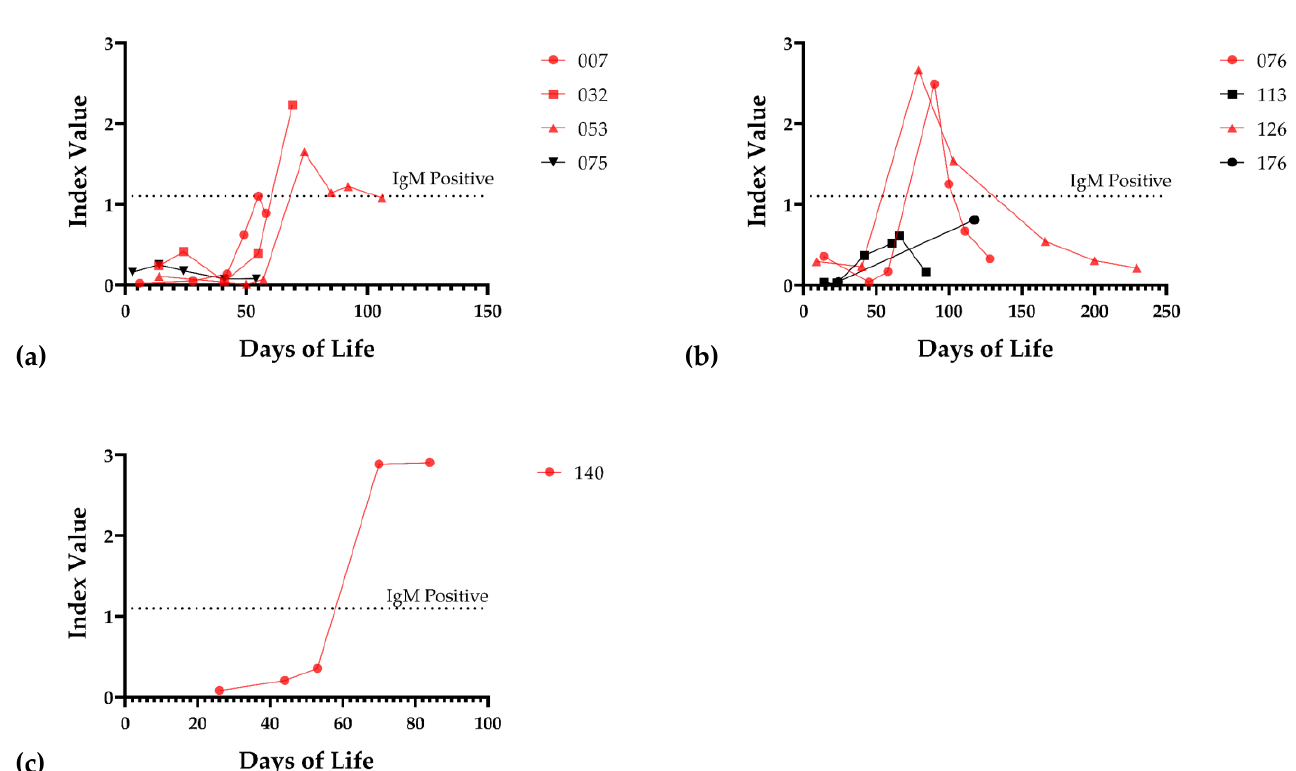
Figure 4. IgM response of infected infants. ( a ) IgM response of viremic infants 007, 032, 053, and 075. ( b ) IgM response of viremic infants 076, 113, 126, and 176. ( c ) IgM response of infant 140. Red lines indicate that the infant mounted a positive IgM response at some point during the hospital stay; the threshold of detection for the IgM assay is shown (dotted line).